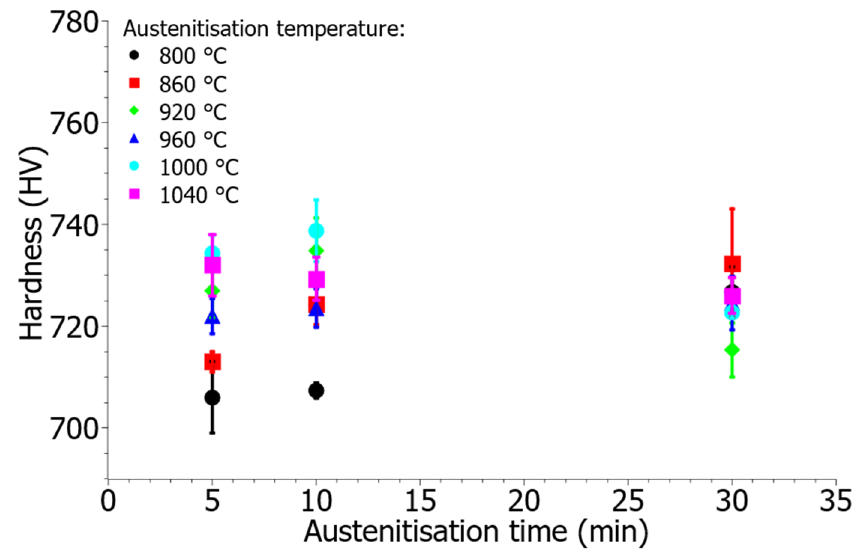
Figure 9. The hardness of the quenched samples.